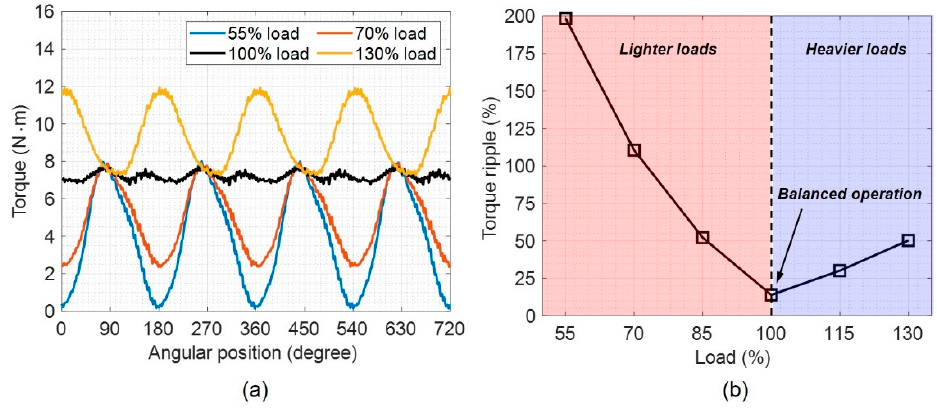
Figure 6. ( a ) The torque waveform and ( b ) torque ripple at the different loads.